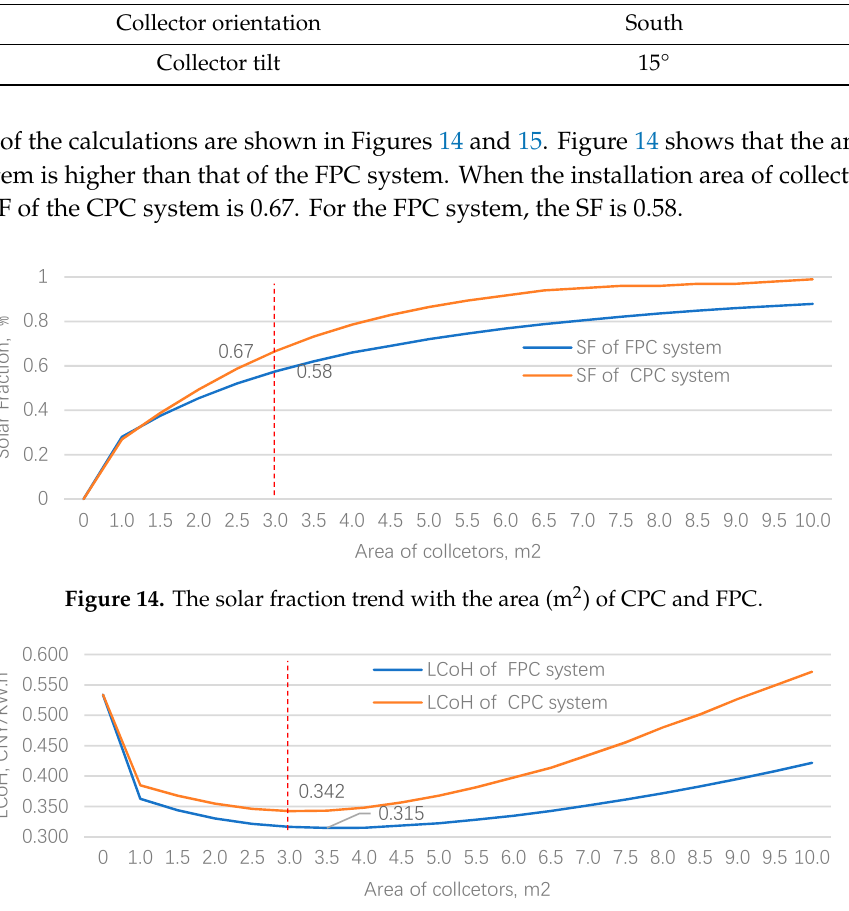
Figure 15. The LCoH curves with the area (m 2 ) of collectors with different types of collectors.